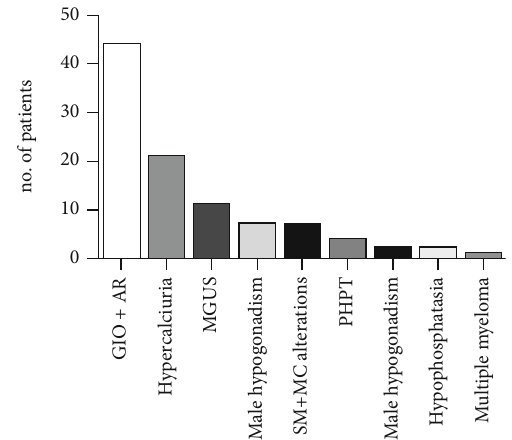
Figure 3: Causes of secondary osteoporosis in the analyzed patients ’ series. GIO : glucocorticoid-induced osteoporosis; AR: rheumatoid arthritis and connectivities; hypercalciuria : idiopathic hypercalciuria; MGUS : monoclonal gammopathy of undetermined signi fi cance; PHPT : primary hyperparathyroidism; SM : systemic mastocytosis; MC : mast